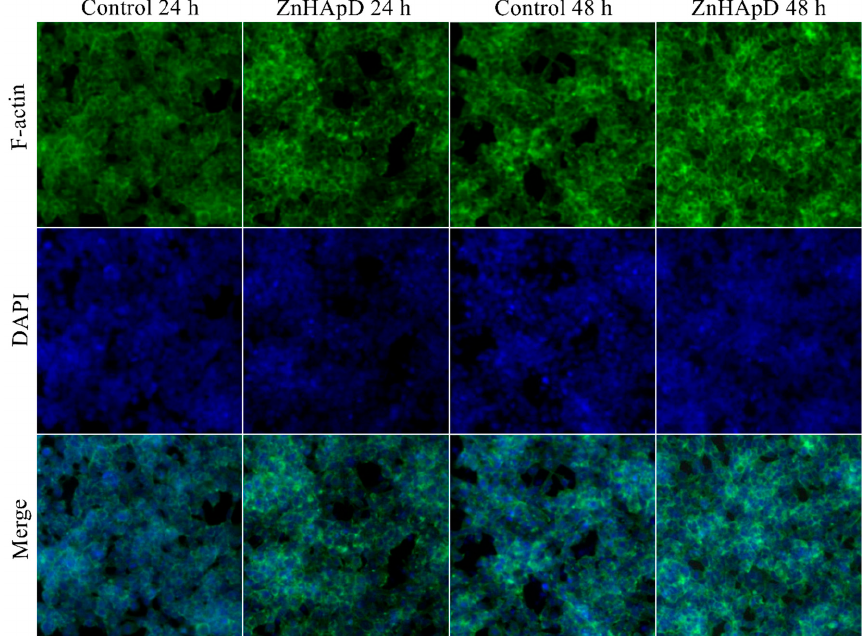
Figure 13. Images obtained by fluorescence microscopy after 24 and 48 hours of HEK-293 cell cultured in the presence of a 500 μ g/mL ZnHApD solution. Actin cytoskeleton of cells, stained with phalloidin-FITC (green). The nuclei were stained with DAPI (blue).